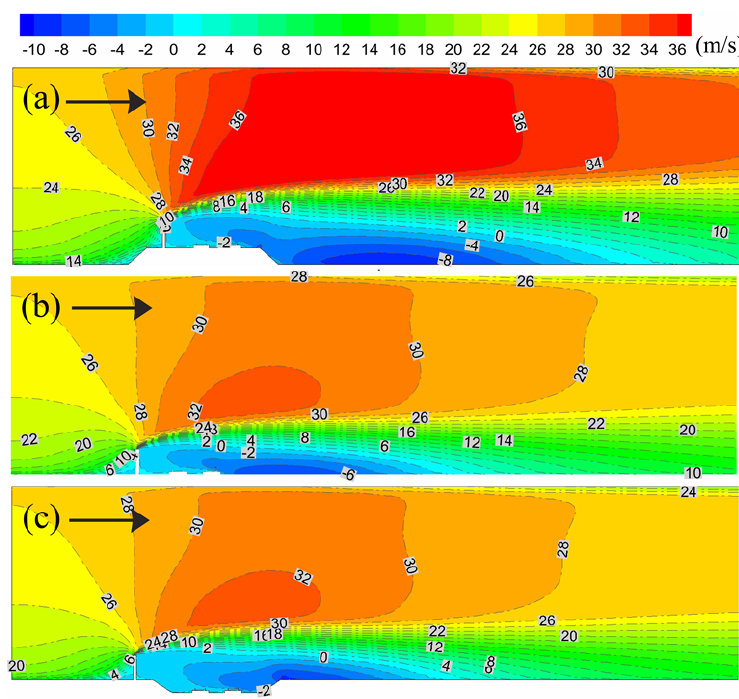
Figure 8. Wind fields around wind-break walls ( u ∗ = 0.9701 m/s): ( a ) convex subgrade, ( b ) flat subgrade, and ( c ) concave